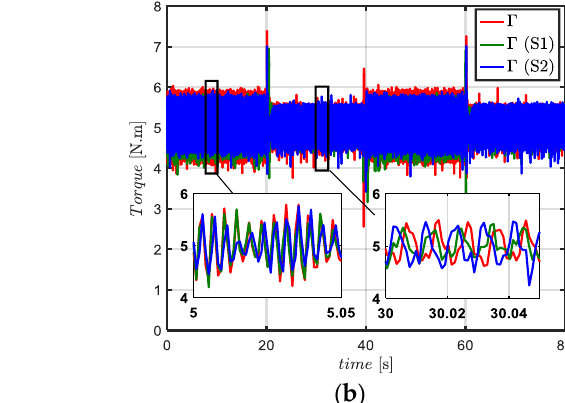
Figure 26. Experimental waveforms: ( a ) measured and estimated rotor speed, ( b ) measured torque when the seven-phase PMSM is controlled by the encoder, sensorless control ( S1 ), and sensorless control ( S2 ).